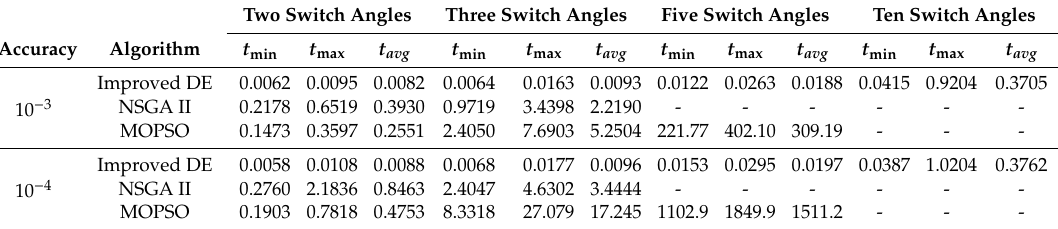
Table 1. Time required for three algorithms to solve dual-frequency PHM switching angles with di ff erent accuracy (time unit: second).